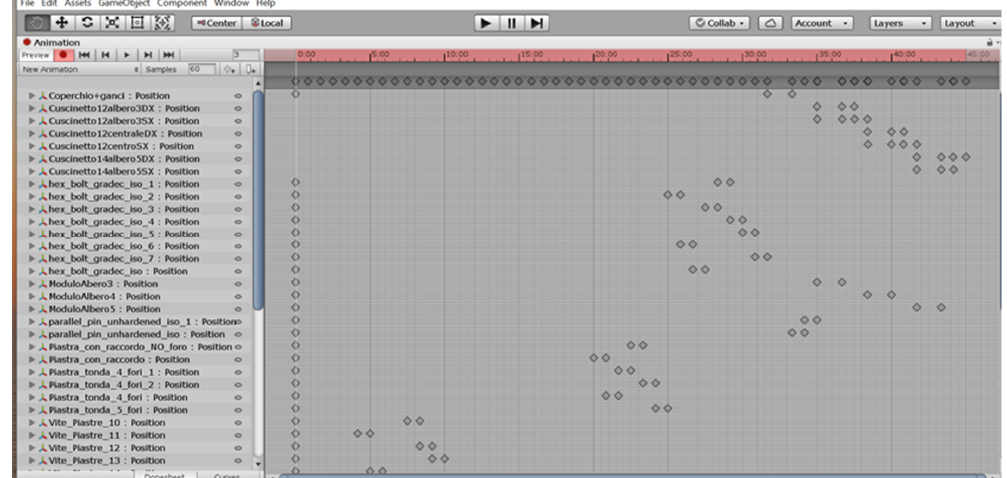
Figure 15. Animation of the Game Object.